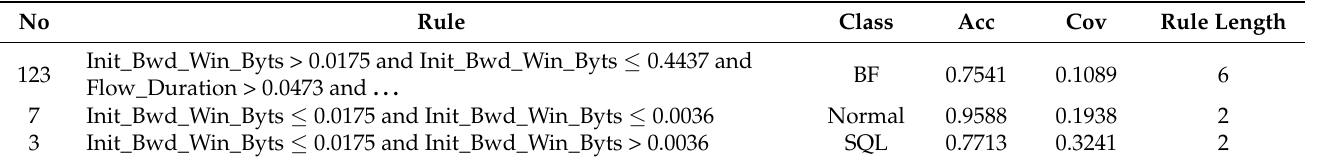
Table 8. Representative Rules.